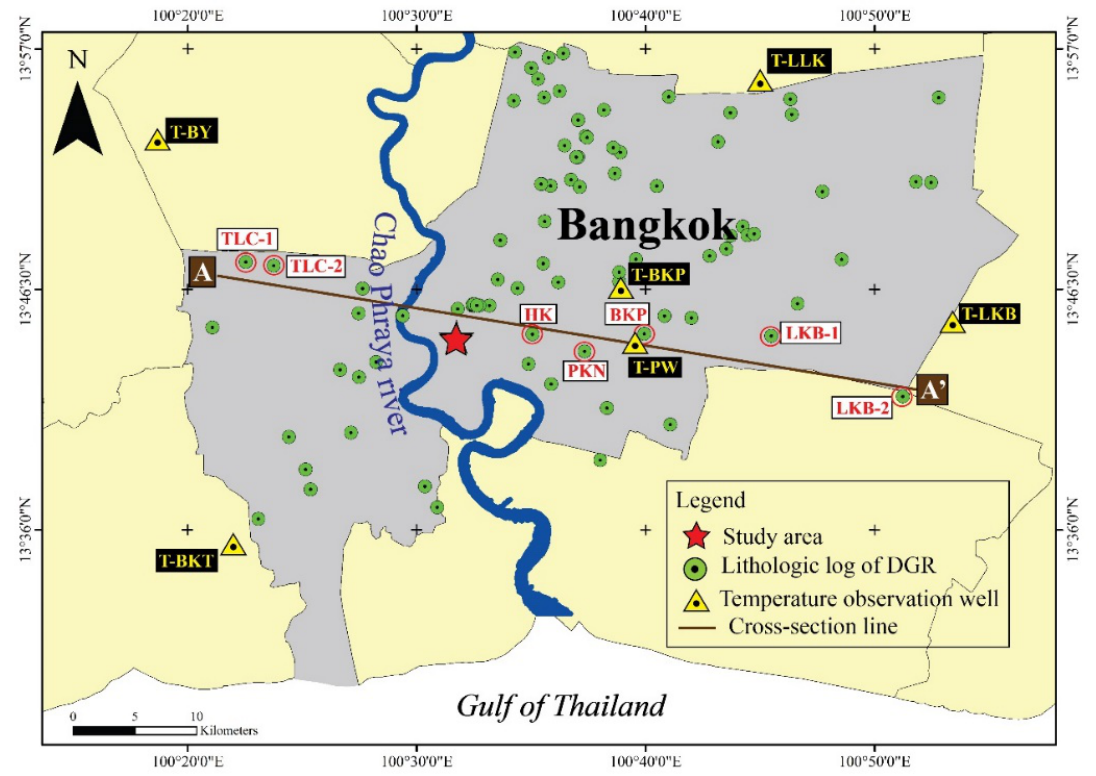
Figure 4. Index map of the Lower Chao Phraya Plain showing the locations of the study area (red star) and lithologic log (green circle) with A-A’ cross section line (data from Department of Groundwater Resources (DGR) and Index map of Lower Chao Phraya Plain showing the locations of temperature observation wells around Bangkok (yellow triangle). The eastern part of Bangkok includes T-LLK and T-LKB. The central part of Bangkok includes T-BKP and T-PW. The western part of Bangkok includes T-BKT and